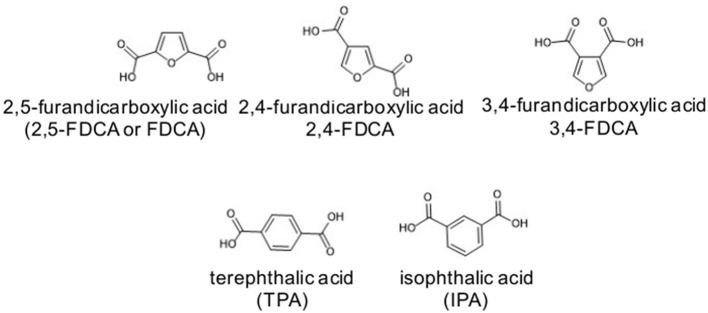
Chemical structures of 2,5-FDCA, 2,4-FDCA, 3,4-FDCA, TPA, and IPA.